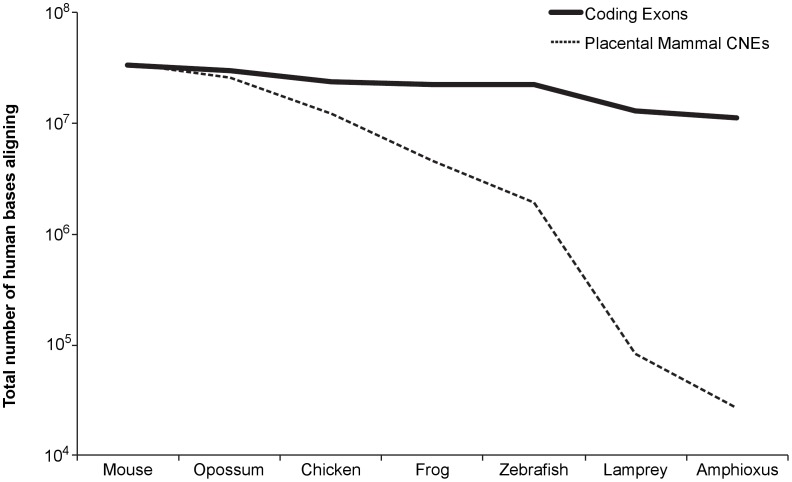
Total number of bases (coding versus conserved non-coding) in human that align to each species.Species are ordered at progressively greater evolutionary distances. Placental mammal CNEs – placental mammal conserved non-coding elements.